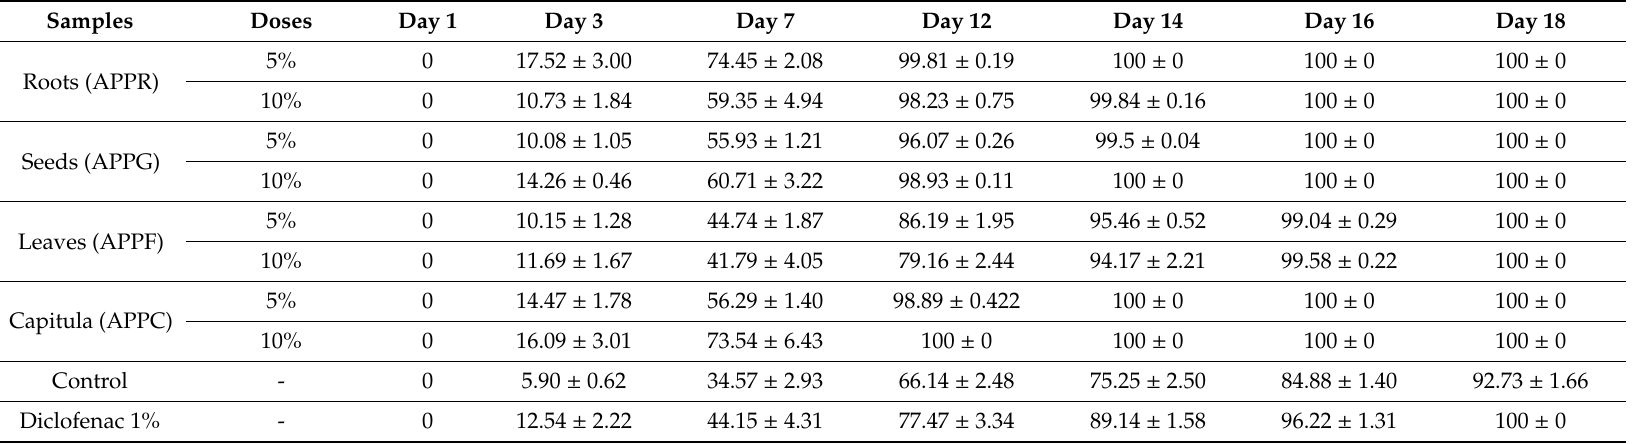
Table 4. The results of the wound healing activity of di ff erent parts of A. pyrethrum (doses of 5% and 10%) and Madecasol compared to the negative control.